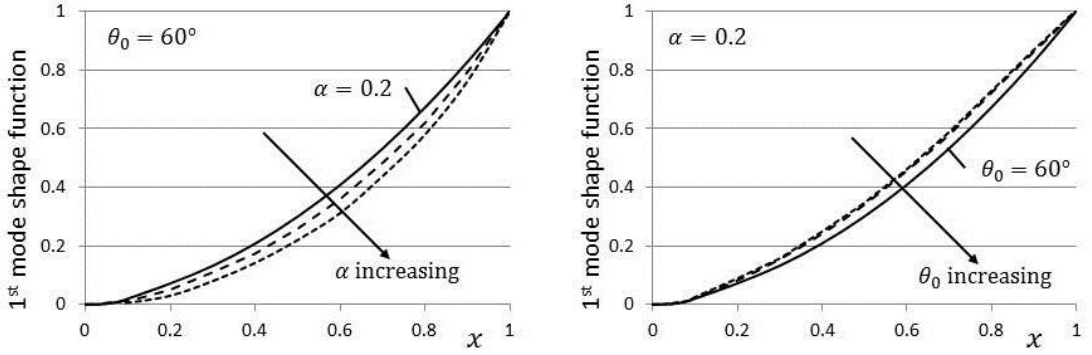
Figure 7. Variation of the first mode shape function, with λ 2 = 1.0.